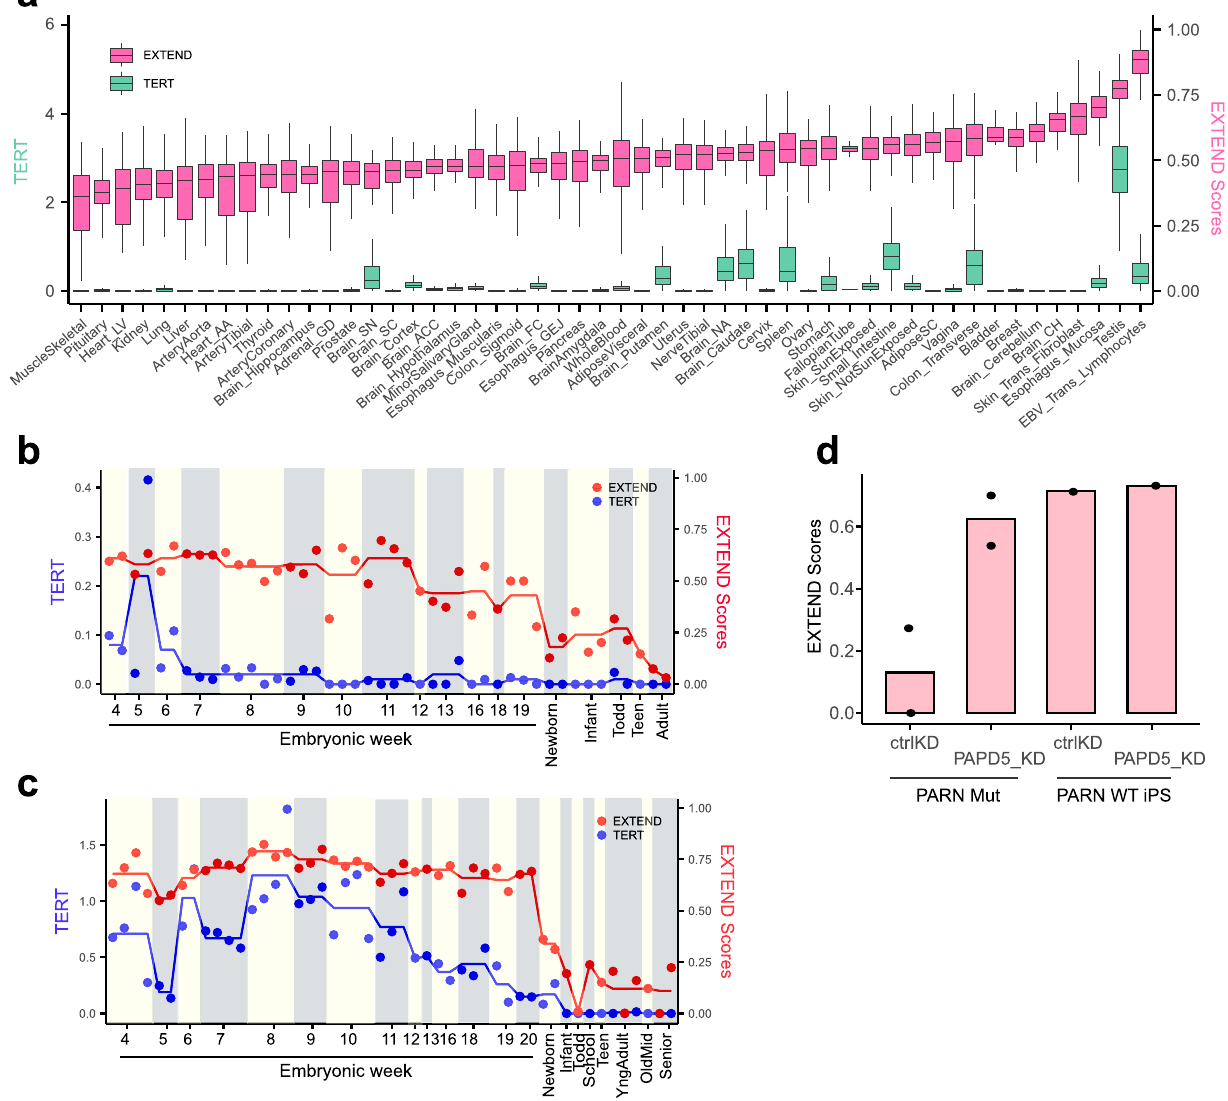
Fig. 2 EXTEND scores across normal tissues and during embryonic development. a EXTEND scores and TERT expression across 52 sub-tissues across Genotype Tissue Expression (GTEx) data ( n = 11,688). The left y -axis indicates TERT expression (sea green), while the right y -axis represents EXTEND scores (pink). Boxplot interquartile ranges (25 – 75th percentile); middle bar de fi nes median and the minima and maxima are within 1.5 times the interquartile range of the lower and higher quartile. b , c TERT expression (blue) and EXTEND scores (red) across tissue development phases in ( b ) heart tissue and ( c ) liver tissue. Red and blue lines represent the mean of EXTEND scores and TERT expression of samples from each age group. d EXTEND predicts higher telomerase activity in PARN mutant ( n = 2) and PARD5 knockout ( n = 2) sample (left two bars), whereas no such effect is observed in PARN wild-type iPS cells ( n = 1 for each case) (right two bars). Data are downloaded from “ GSE81507. ” Data used for the fi gure is available in Source